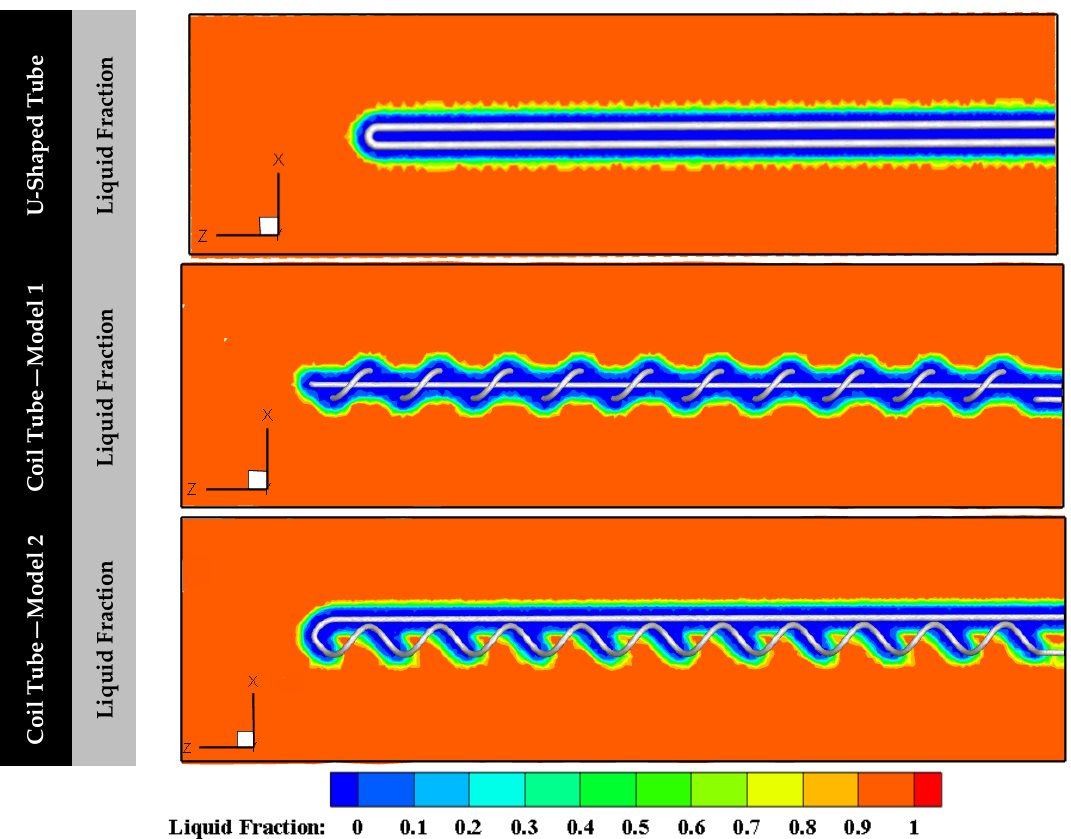
Figure 10. Contours of liquid fraction and temperature (K) for three types of tube in the horizontal position after 5 h and at midplane Y = 0.